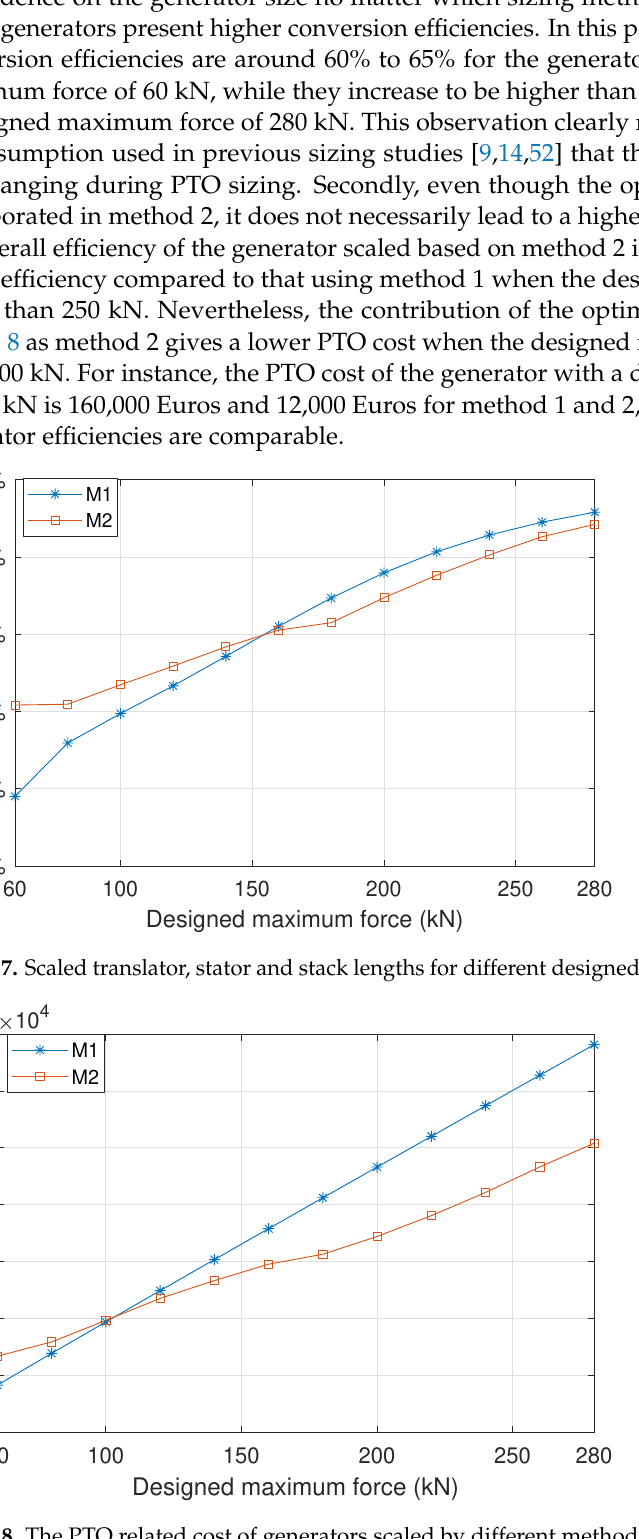
Figure 8. The PTO related cost of generators scaled by different